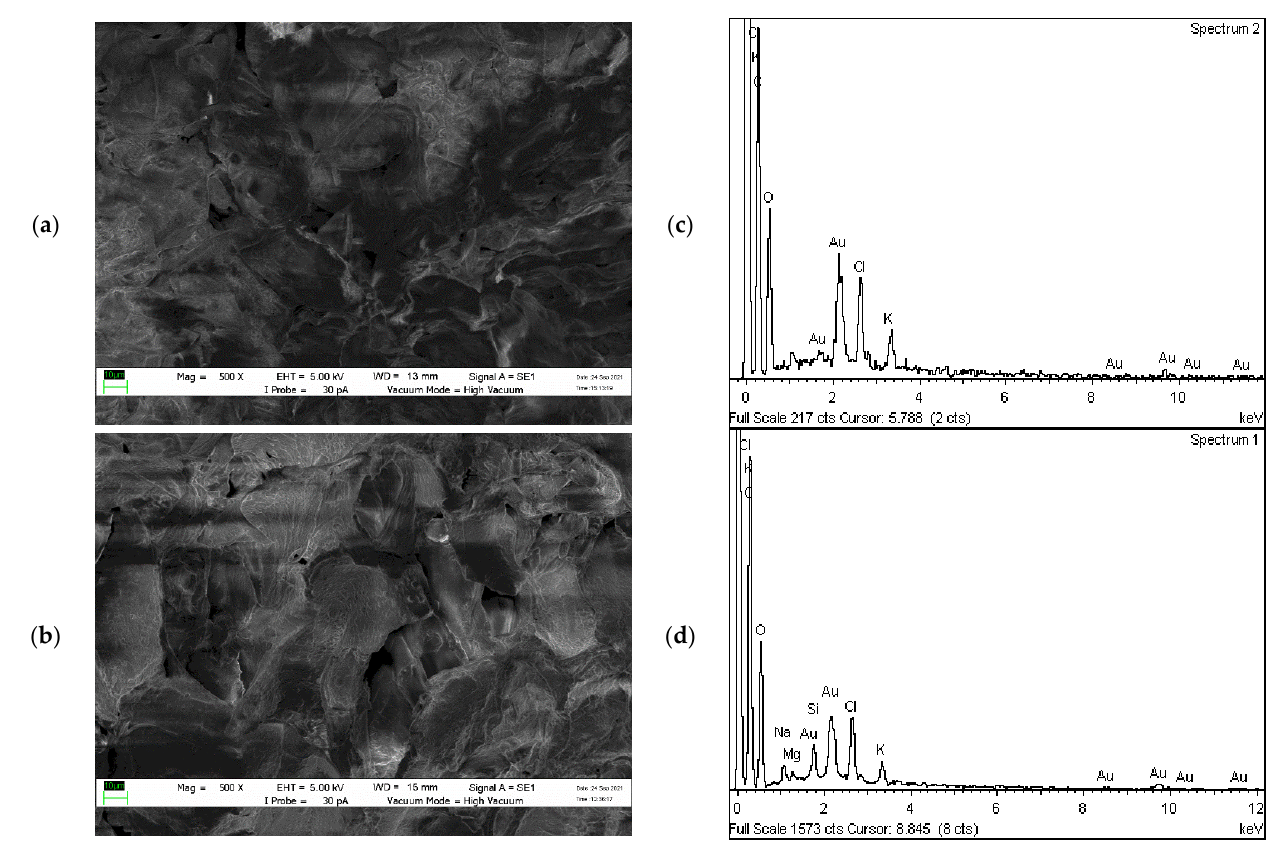
Figure 4. SEM and EDX analysis after filtration: ( a , c ) UNT CP and ( b , d ) T CP.